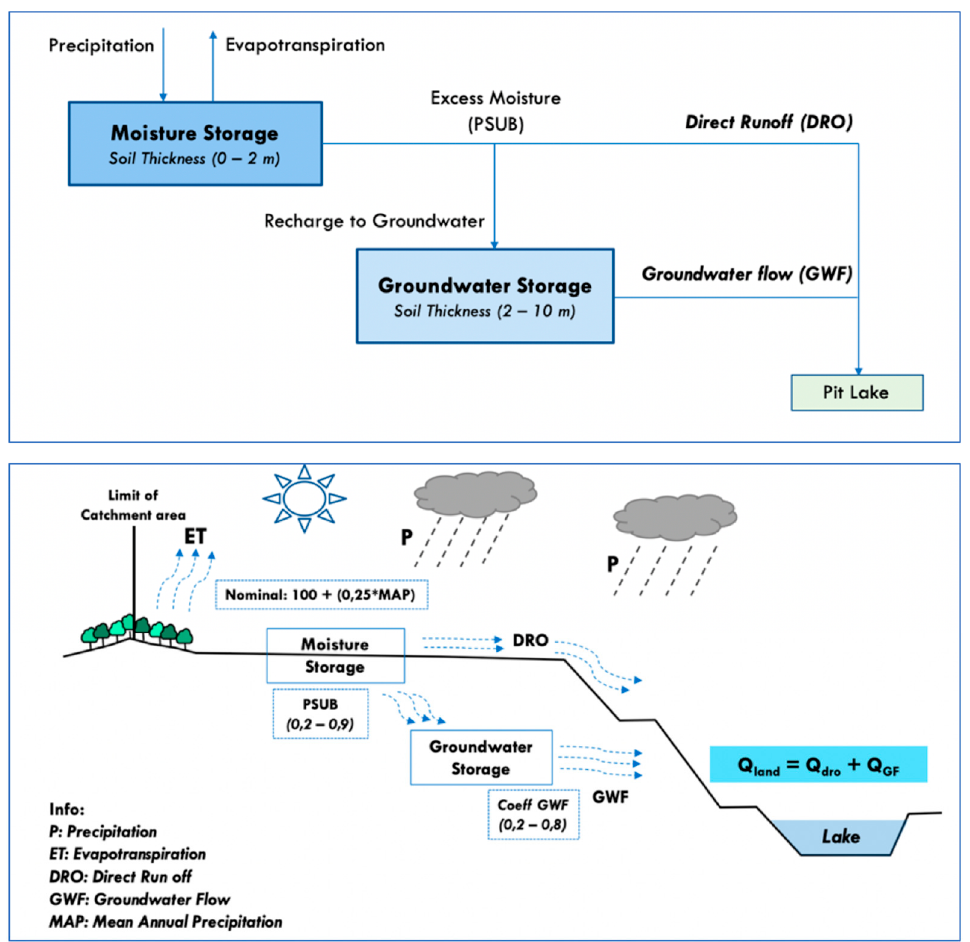
Figure 4. Overland zone—NRECA model.